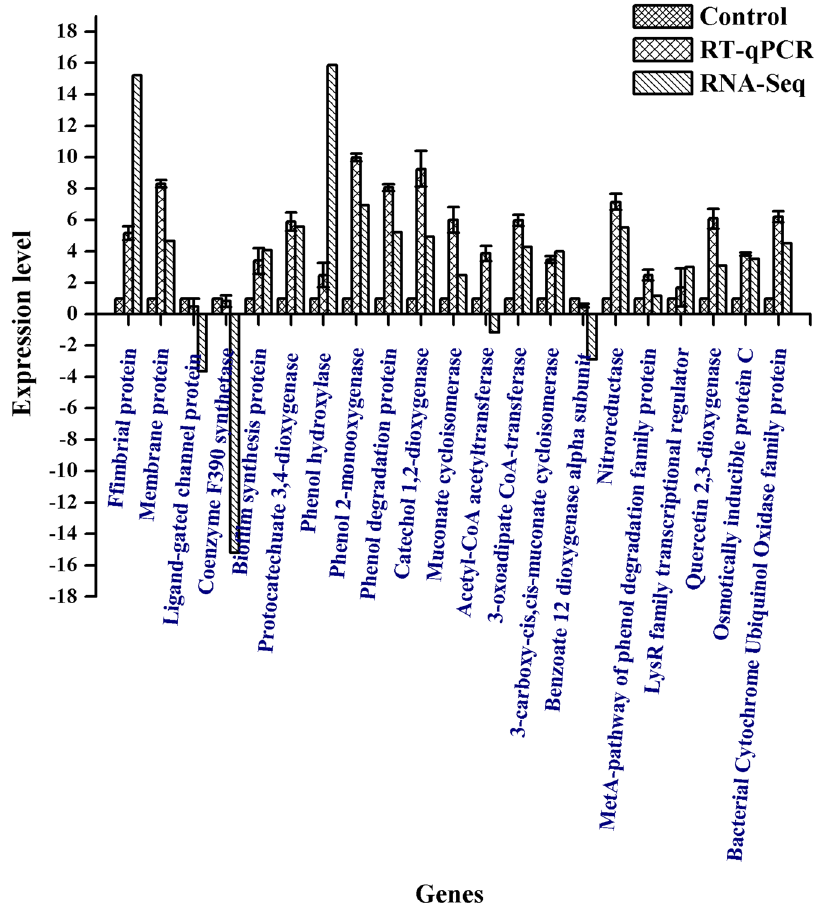
Figure 8. Validation of transcriptome data by quantitative RT-PCR analysis. Log2 fold changes calculated with both RT-qPCR and RNA-Seq